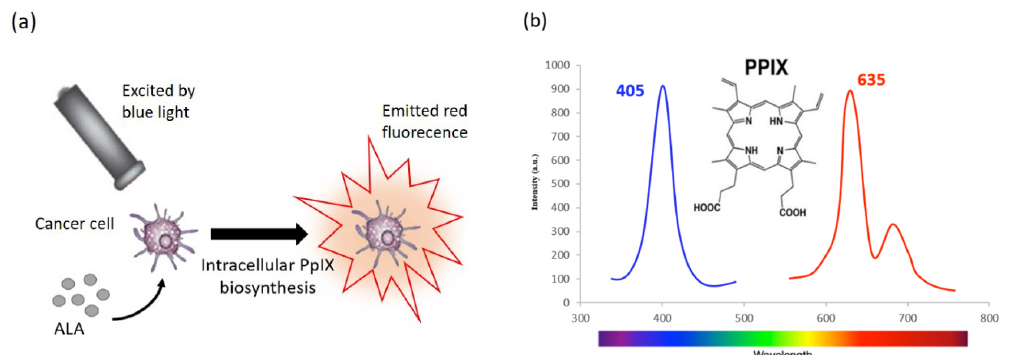
Figure 2. The principle of photodynamic diagnosis (PDD) of 5-ALA mediated protoporphyrin IX (PpIX) in tumour cells ( a ); molecular structure of PpIX and fluorescence spectrum ( b ), following excitation with violet blue light at 405 nm, PpIX emits a red fluorescence of 635 nm.